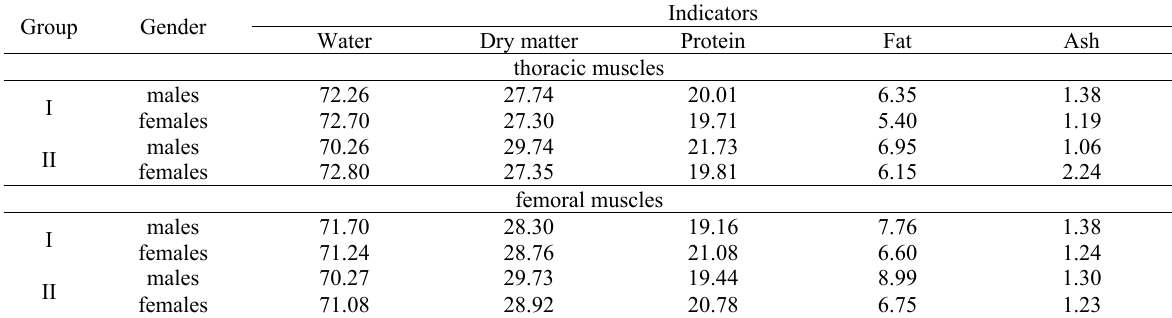
Chemical composition of the thoracic and femoral muscles of geese at 9 weeks of age,% of crude mass